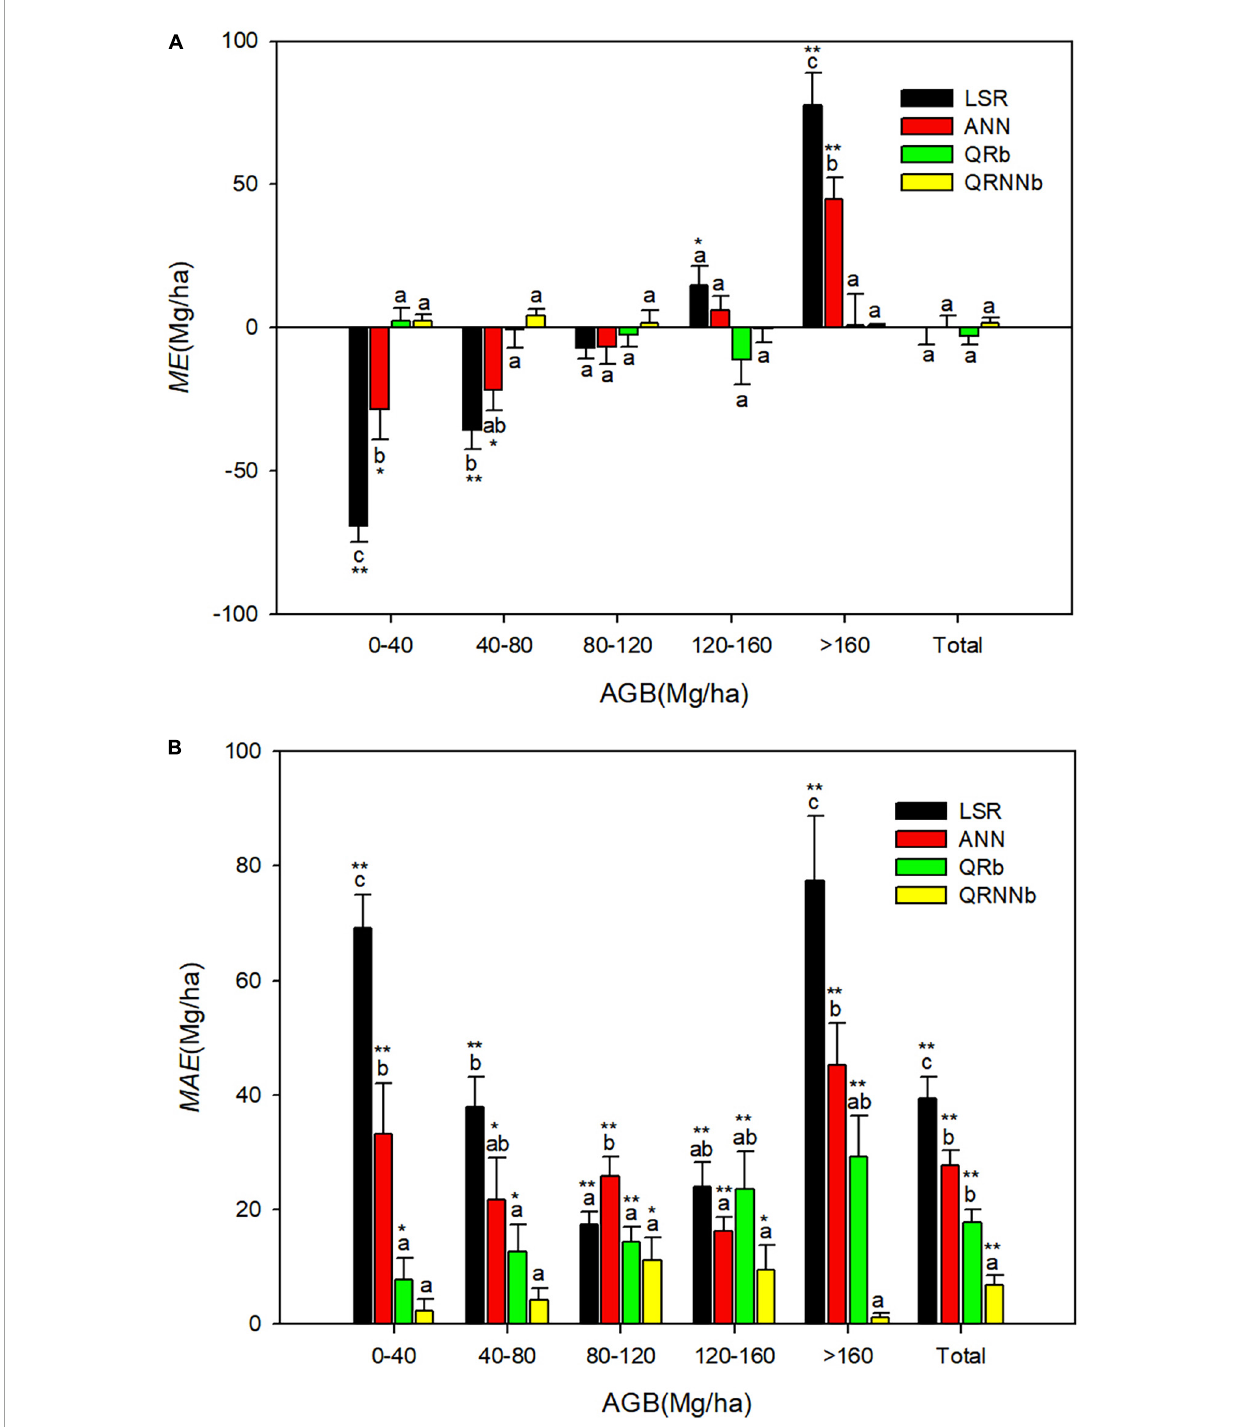
FIGURE5 The statistical results of significant differences in the mean errors from zero. (A) The statistical test results of significant differences of mean errors from zero; (B) the statistical test results of significant differences of mean absolute error (LSR, linear stepwise regression; ANN, artificial neural network; QRb, best quantile regression in each biomass segment; QRNNb, best quantile regression neural network in each biomass segment; AGB, aboveground biomass; ME, mean error; MAE, mean absolute error; * and ** represent significant levels of 0.05 and 0.01,